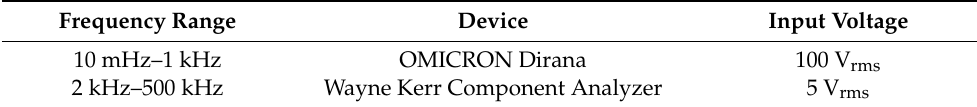
Table 1. Frequency domain measurement